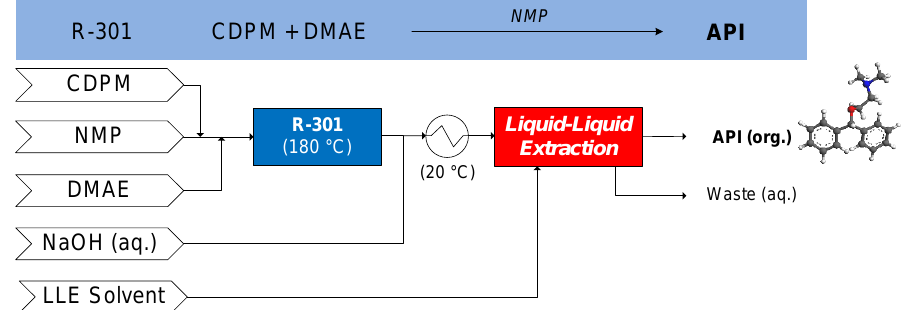
Figure 13. CPM flowsheet for diphenhydramine: flow synthesis [65] + continuous LLE [66]. Reproduced with permission from Diab and Gerogiorgis, Organic Process Research & Development; published by American Chemical Society, 2017.